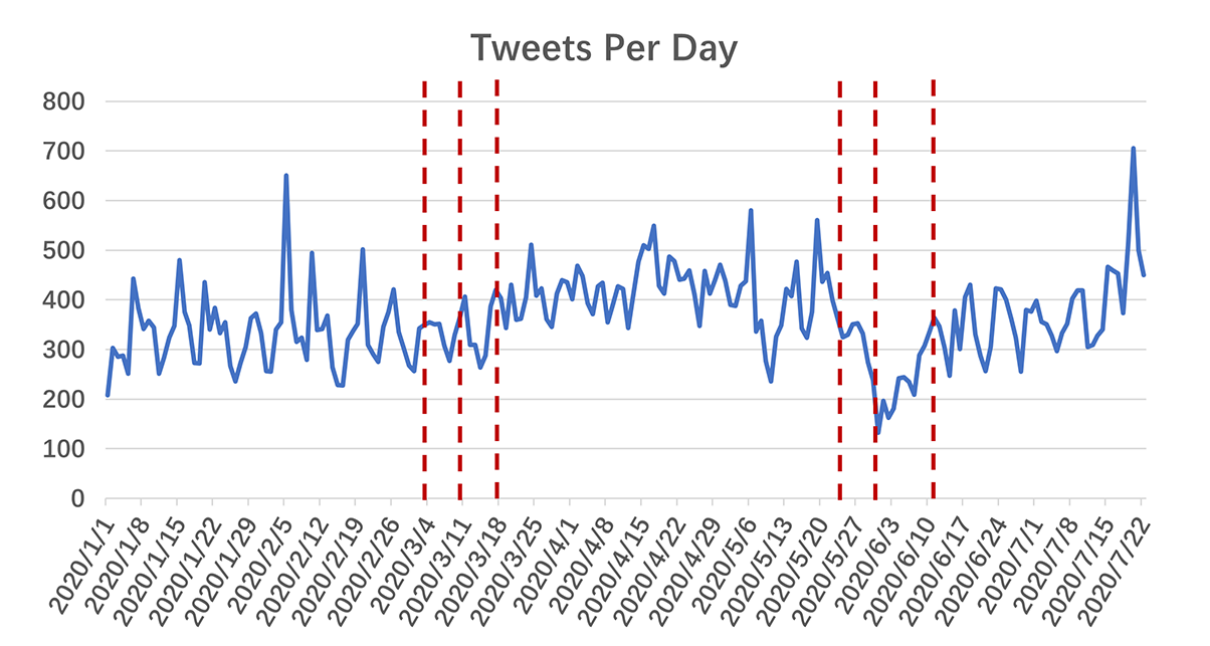
Figure 1. Frequency of tweets related to the top plastic procedures. The dashed red lines indicate landmark events and the days around them that were excluded from the data collection